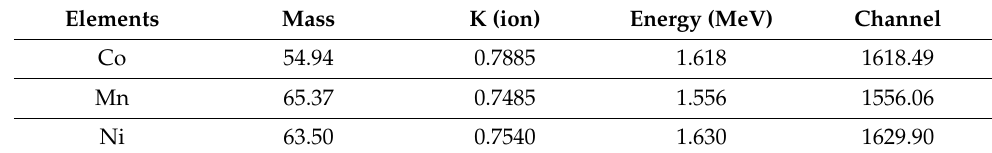
Table 3. RBS spectra parameters for Pristine Co 3 O 4 @MnO 2 @NiO/GO Electrode.